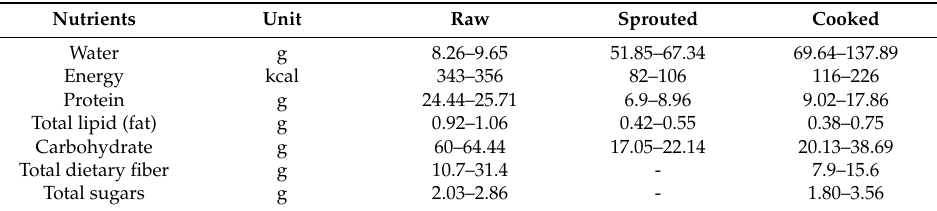
Table 1. Nutritional compositions of lentils in 100 g of the edible portion